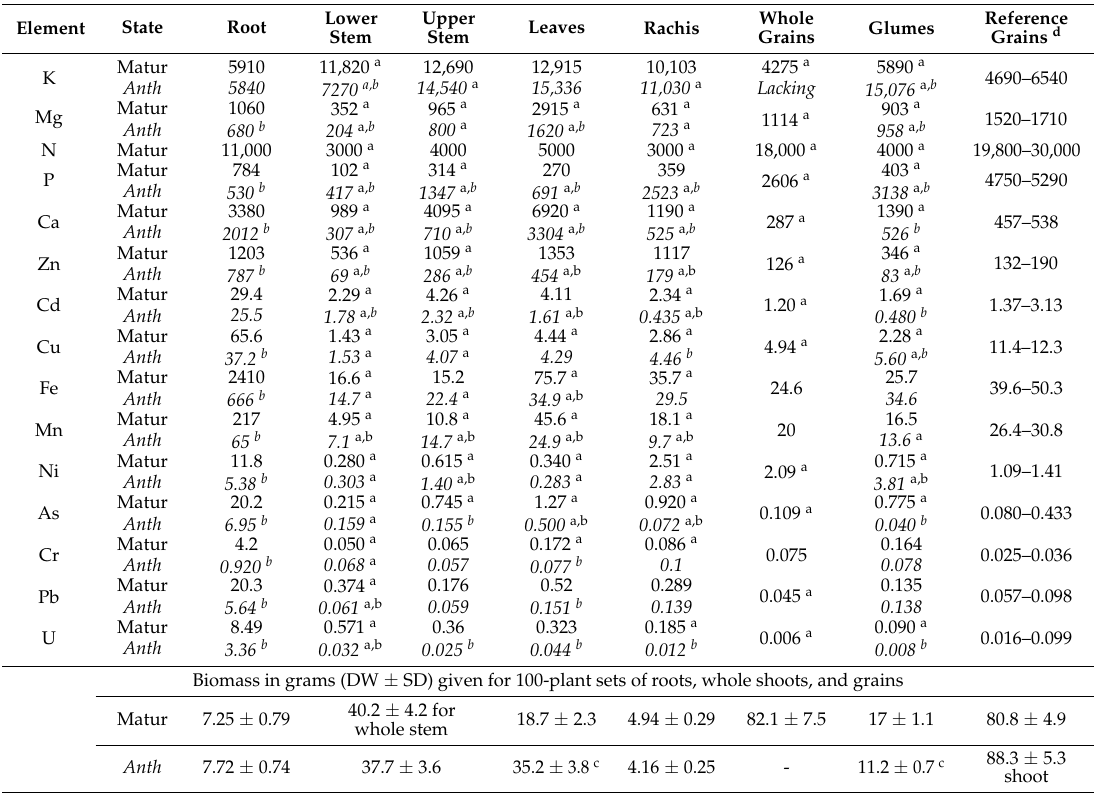
Table 3. The course of mineral concentrations (mg · kg − 1 · DW) across the plant sections of wheat cv. JB Asano in the states of maturity (18 July) and anthesis (22 May). The plants were grown on uranium gradient soil A.